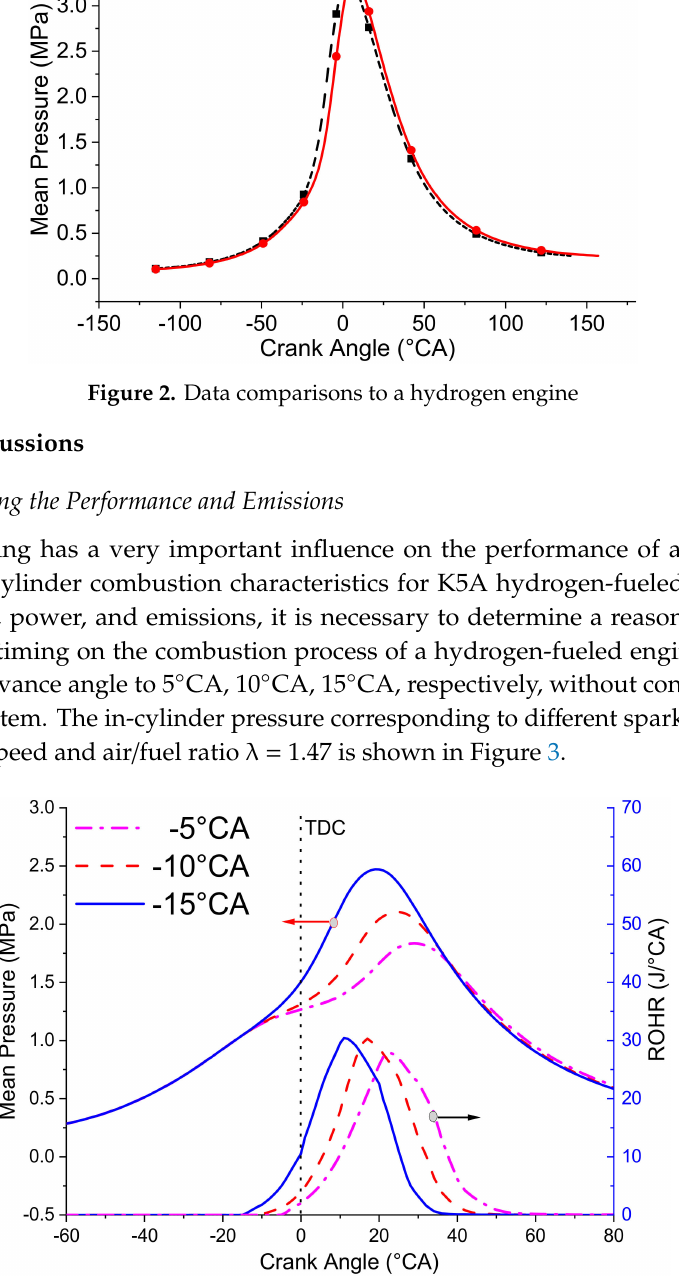
Figure 3. Pressure and heat release rate at di ff erent spark